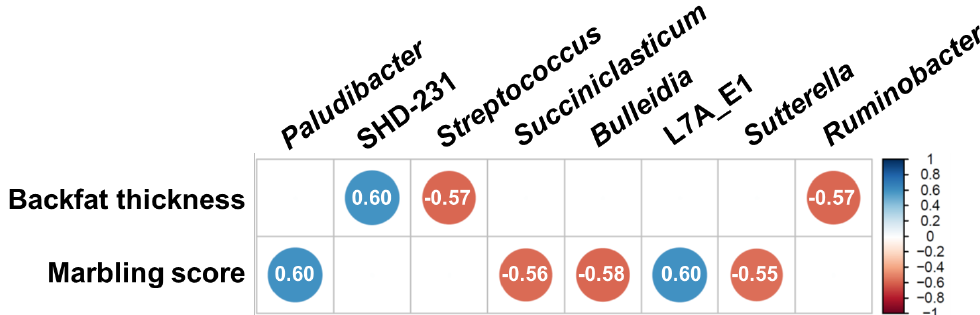
Figure 6. Correlation coefficient matrix between meat quality measurements and relative abundances of major bacterial genera each found in more than 50% of the 14 rumen samples. Only significant correlations ( p < 0.05, | r | > 0.5) are shown. The degree of correlation coefficients are shown using both the color and size of the circles based on the color key on the right